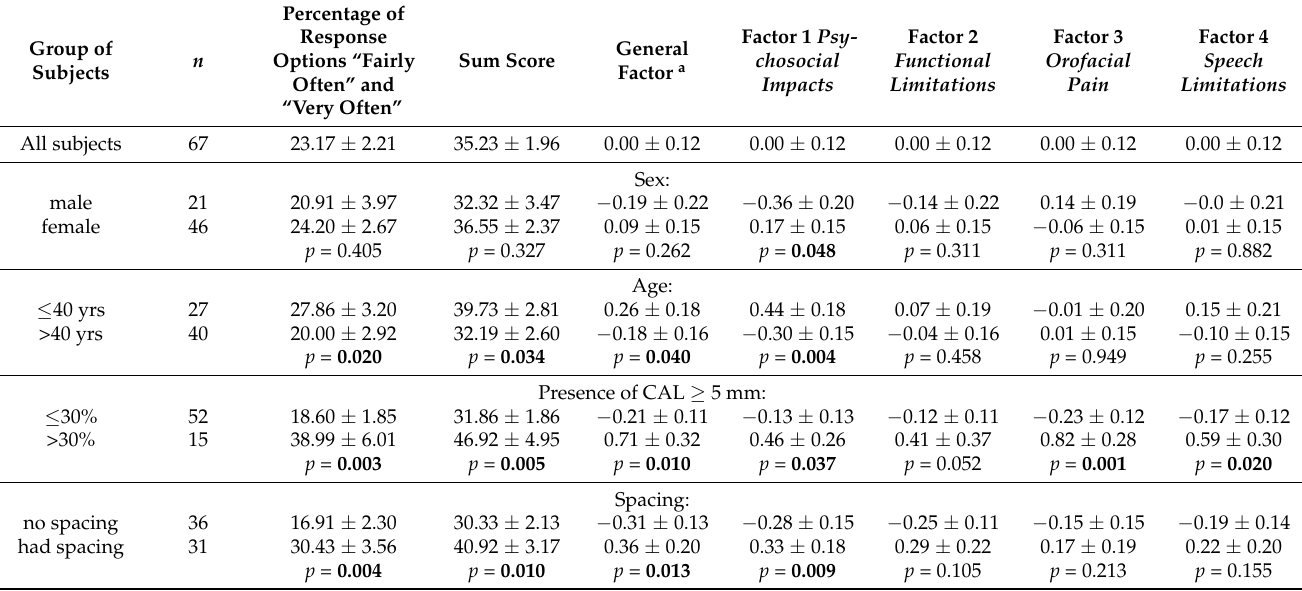
Table 6. Results of discriminative validity analysis: means ± SE of the OHIP-LT estimates, by demographic and clinical groups of